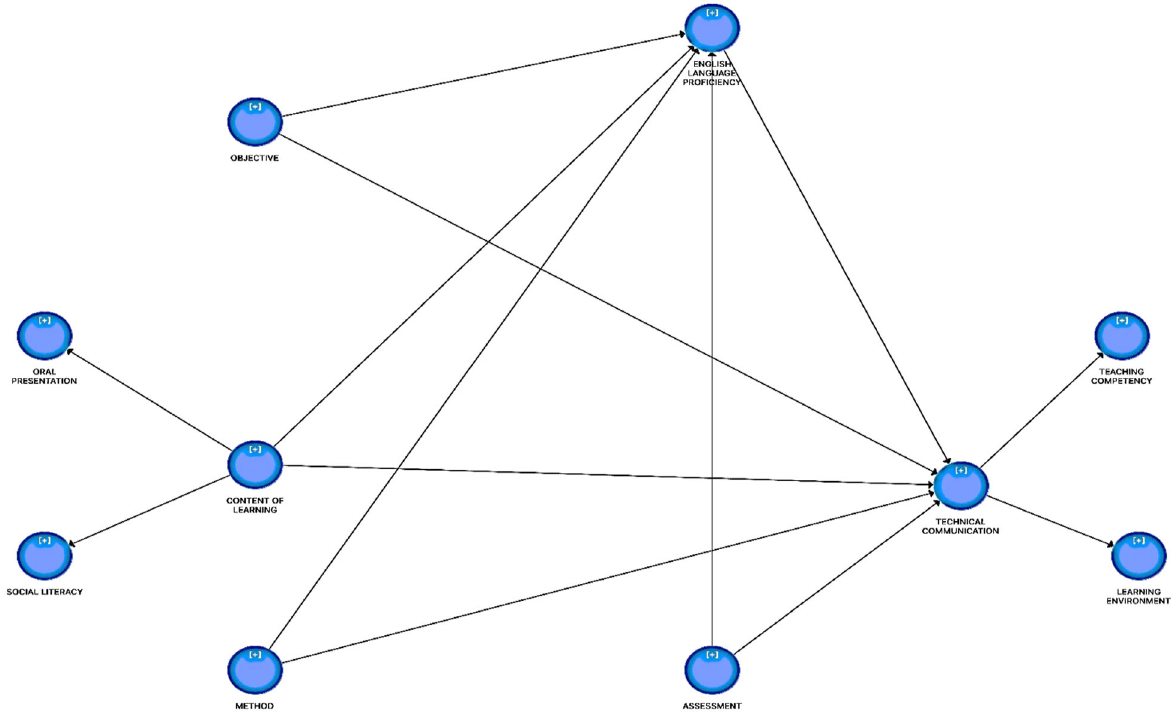
Fig. 1 The proposed initial measurement model. Representation of the four exogenous constructs (objective, content of learning, method, and assessment), the mediator (English language pro fi ciency) and the endogenous construct (technical